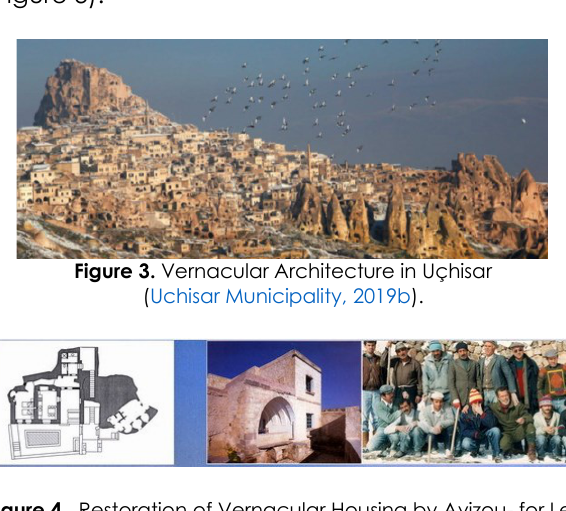
Figure 4. Restoration of Vernacular Housing by Avizou- for Les Maisons de Cappadoce (Archnet,